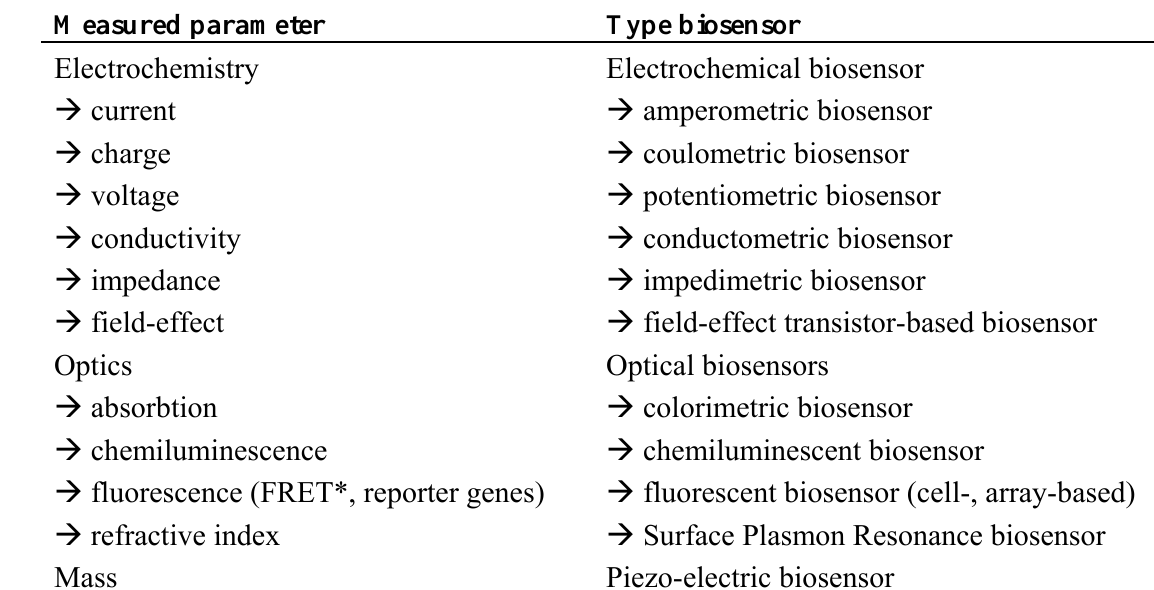
Table 3. Biosensor classification based on the transduction